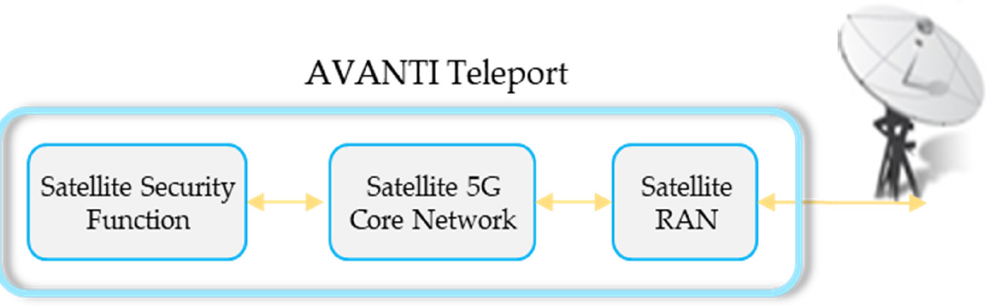
Figure 11. AC-STE-iDirect Teleport: 5G-Enable Intelligent Gateway.